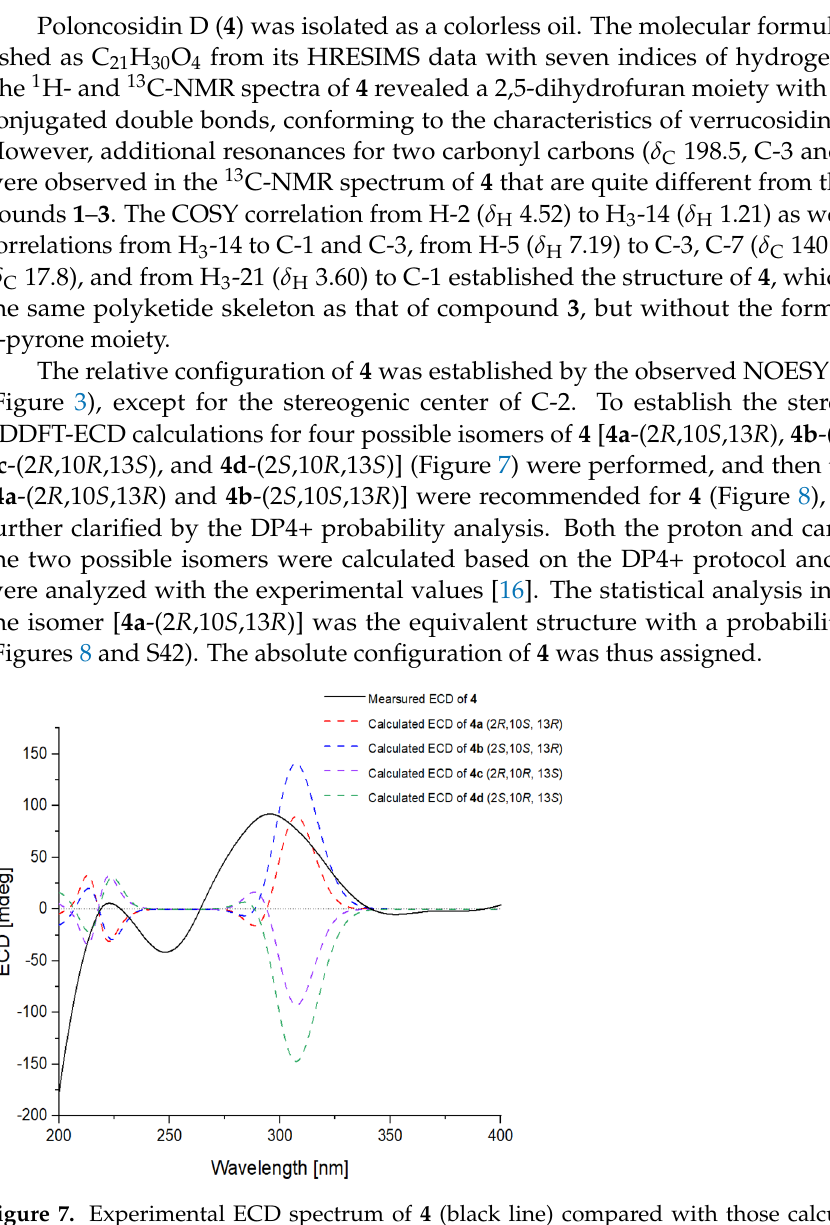
Figure 7. Experimental ECD spectrum of 4 (black line) compared with those calculated for 4a − (2 R ,10 S ,13 R ), 4b − (2 S ,10 S ,13 R ), 4c − (2 R ,10 R ,13 S ), and 4d − (2 S ,10 R ,13 S ) of 4 at BH&HLYP/TZVP level (red, blue, purple and green dashed lines, respectively).